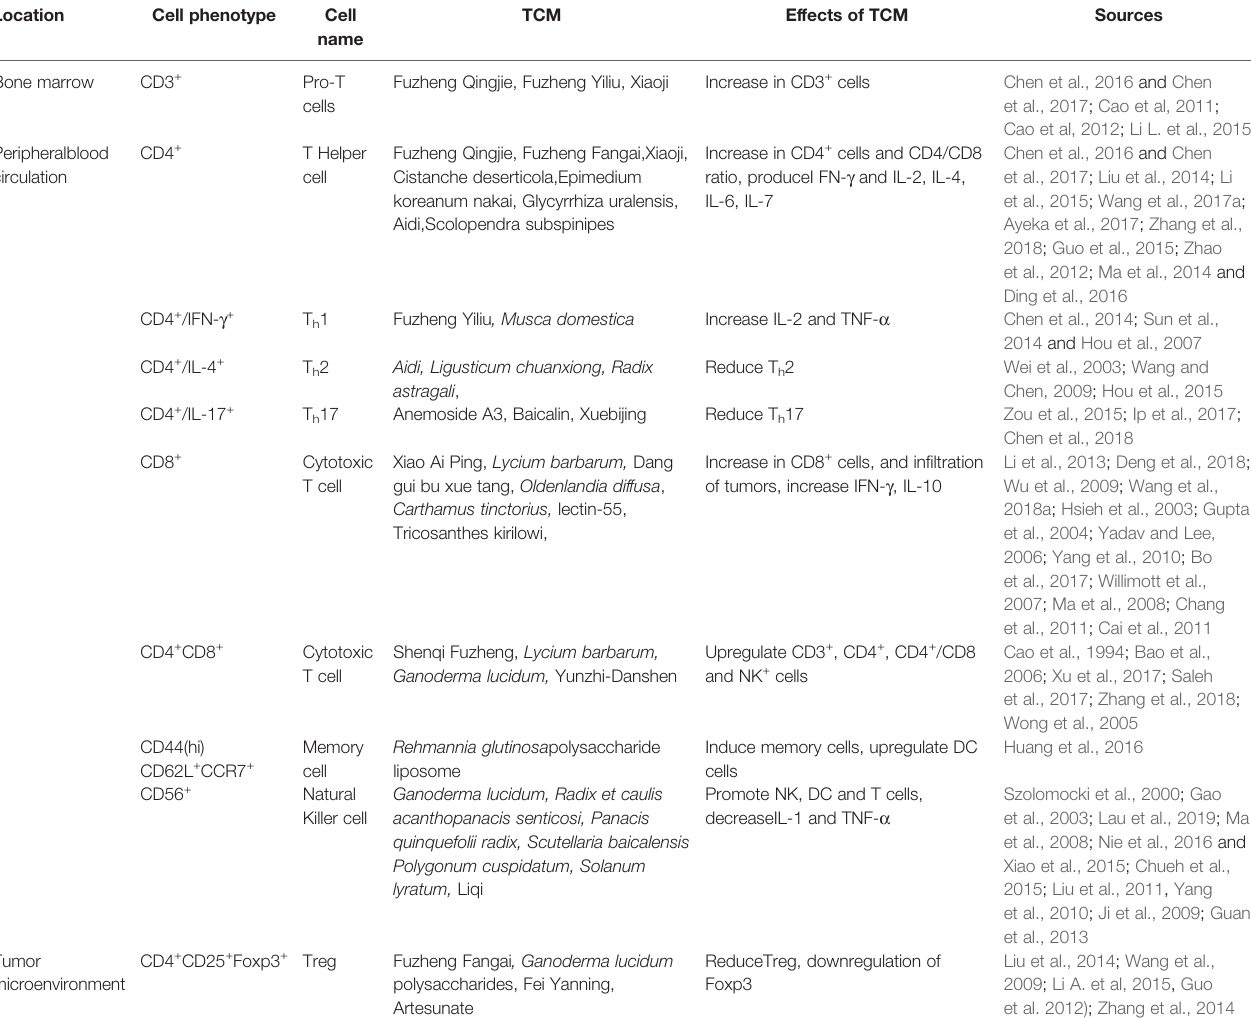
TABLE 1 | The effects of Traditional Chinese herbal medicine on tumor related T